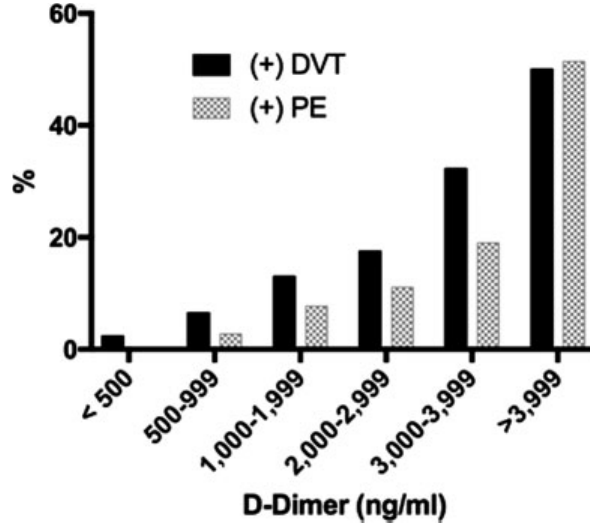
Fig. 2 DVT- and PE-positive patients based on D-dimer values.